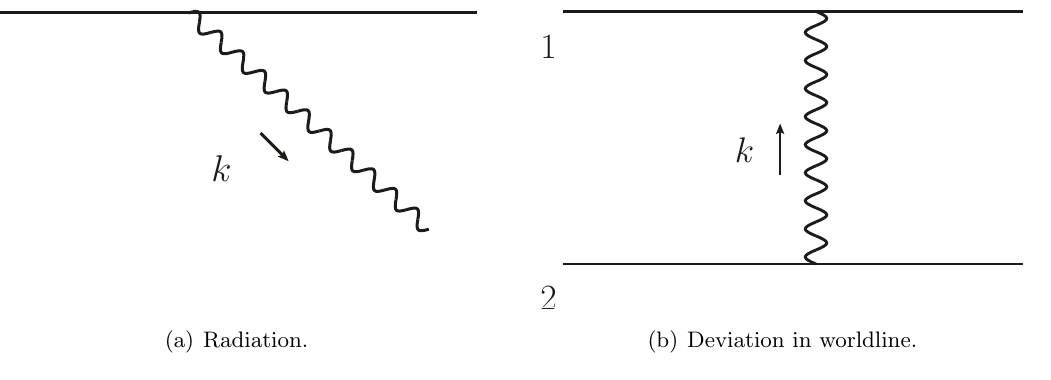
Figure 1 . The diagram on the right is for the radiation in eq. (2.19), and on the left is the diagram for worldline trajectory and color charge in eq. (2.21) and eq. (2.22) respectively. The solid straight lines are massive sources and the wavy lines are